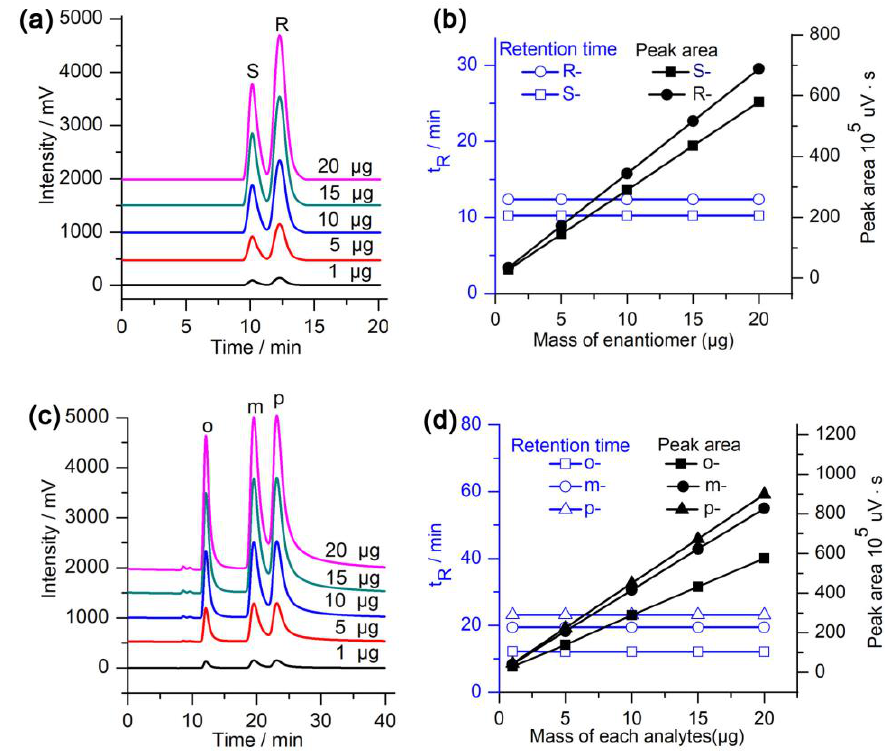
Figure 5. Effect of the injection amount on the separation: ( a , c ) Chromatograms obtained for with various amounts of hydrobenzoin and iodoaniline and ( b , d ) effect of various amounts of hydroben- zoin and iodoaniline on the retention time and peak area. Other chromatographic conditions are the same as those in Tables 1 and 2.